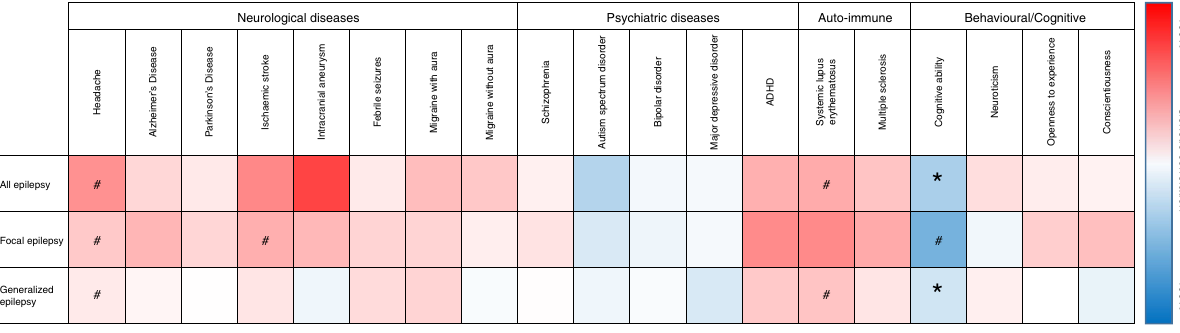
Fig. 5 Genetic correlations of epilepsy with other phenotypes. The genetic correlation coef fi cient, calculated using LD-score regression, is denoted with a color scale ranging from -100% (blue) to 100% (red). #: P < 0.05 * P < 0.001 (Bonferroni threshold;